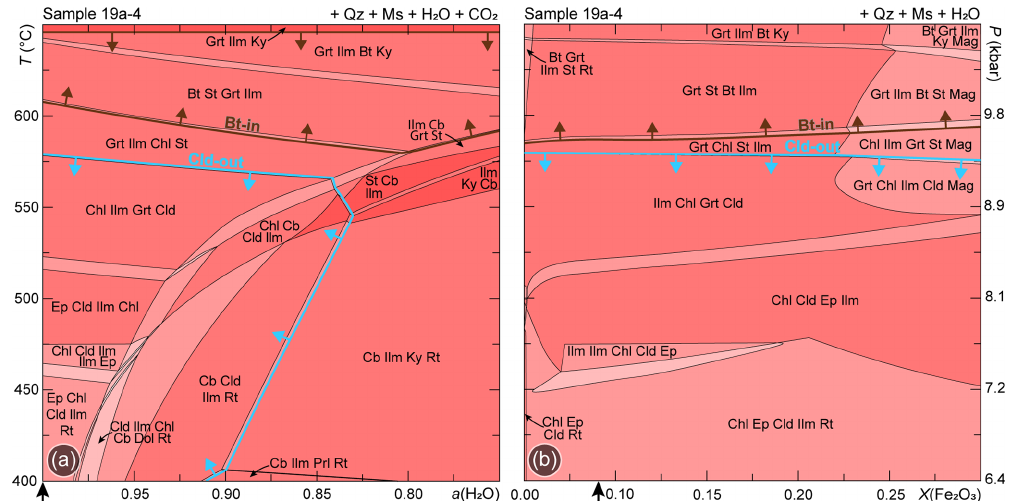
Fig. 1c. The chloritoid-out and the biotite-in reaction curves are highlighted in light blue and brown, respectively. The black arrows indicate the a H 2 O and X (Fe 2 O 3 ) conditions at which the P – T isochemical phase diagrams have been calculated. See Fig. S4 for the same phase diagrams calculated for sample